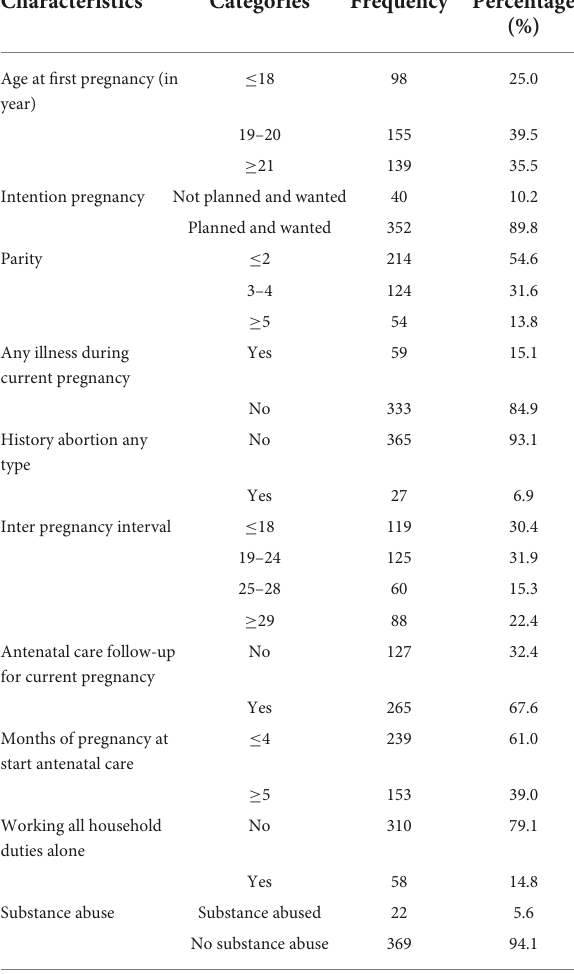
TABLE 3 Reproductive, medical, and behavioral characteristics of pregnant women in Liban District ( n = 420), 2021. Characteristics